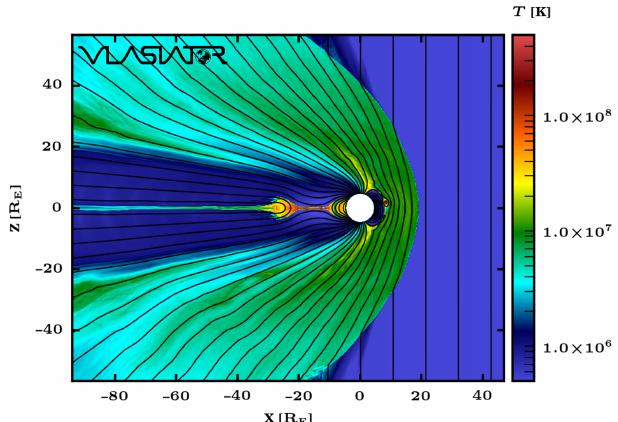
Figure 1. Simulated plasma temperature in the entire simulation do- main at t = 1800s. The white area corresponds to near-Earth space located inside the inner boundary at 4.7 R E . Black lines represent magnetic field lines.